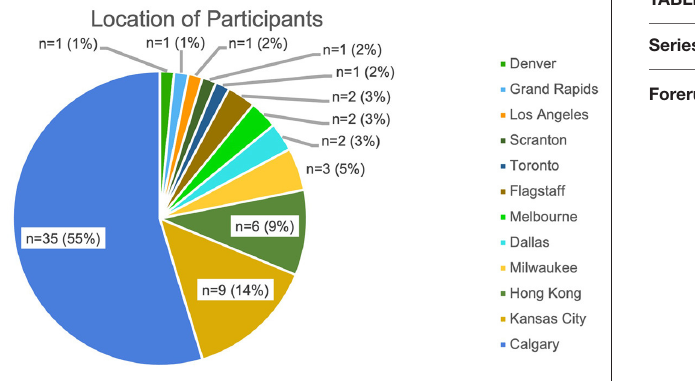
TABLE 2 | Distribution of wearable devices used by